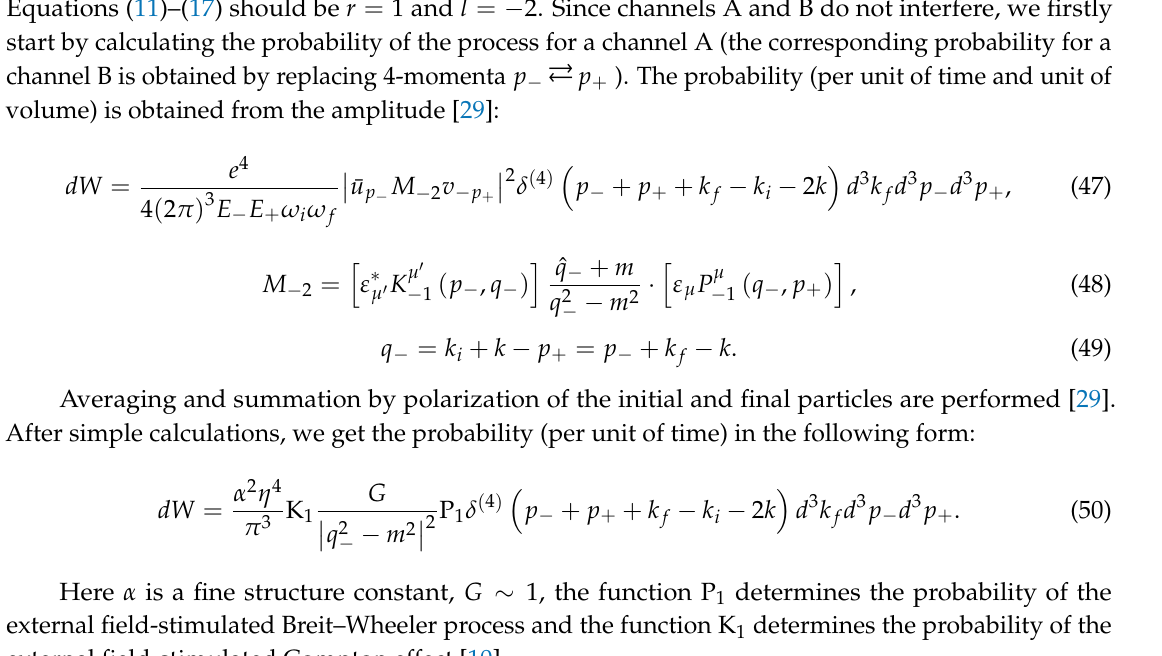
Figure 5. Dependence of the electron energy (in units of the initial gamma quantum energy) on the δ 2 f 1 corresponds to the positron energy, line 2 corresponds to E + = 25 MeV ( x + = 0.05 ) for the positron outgoing at an angle δ 2